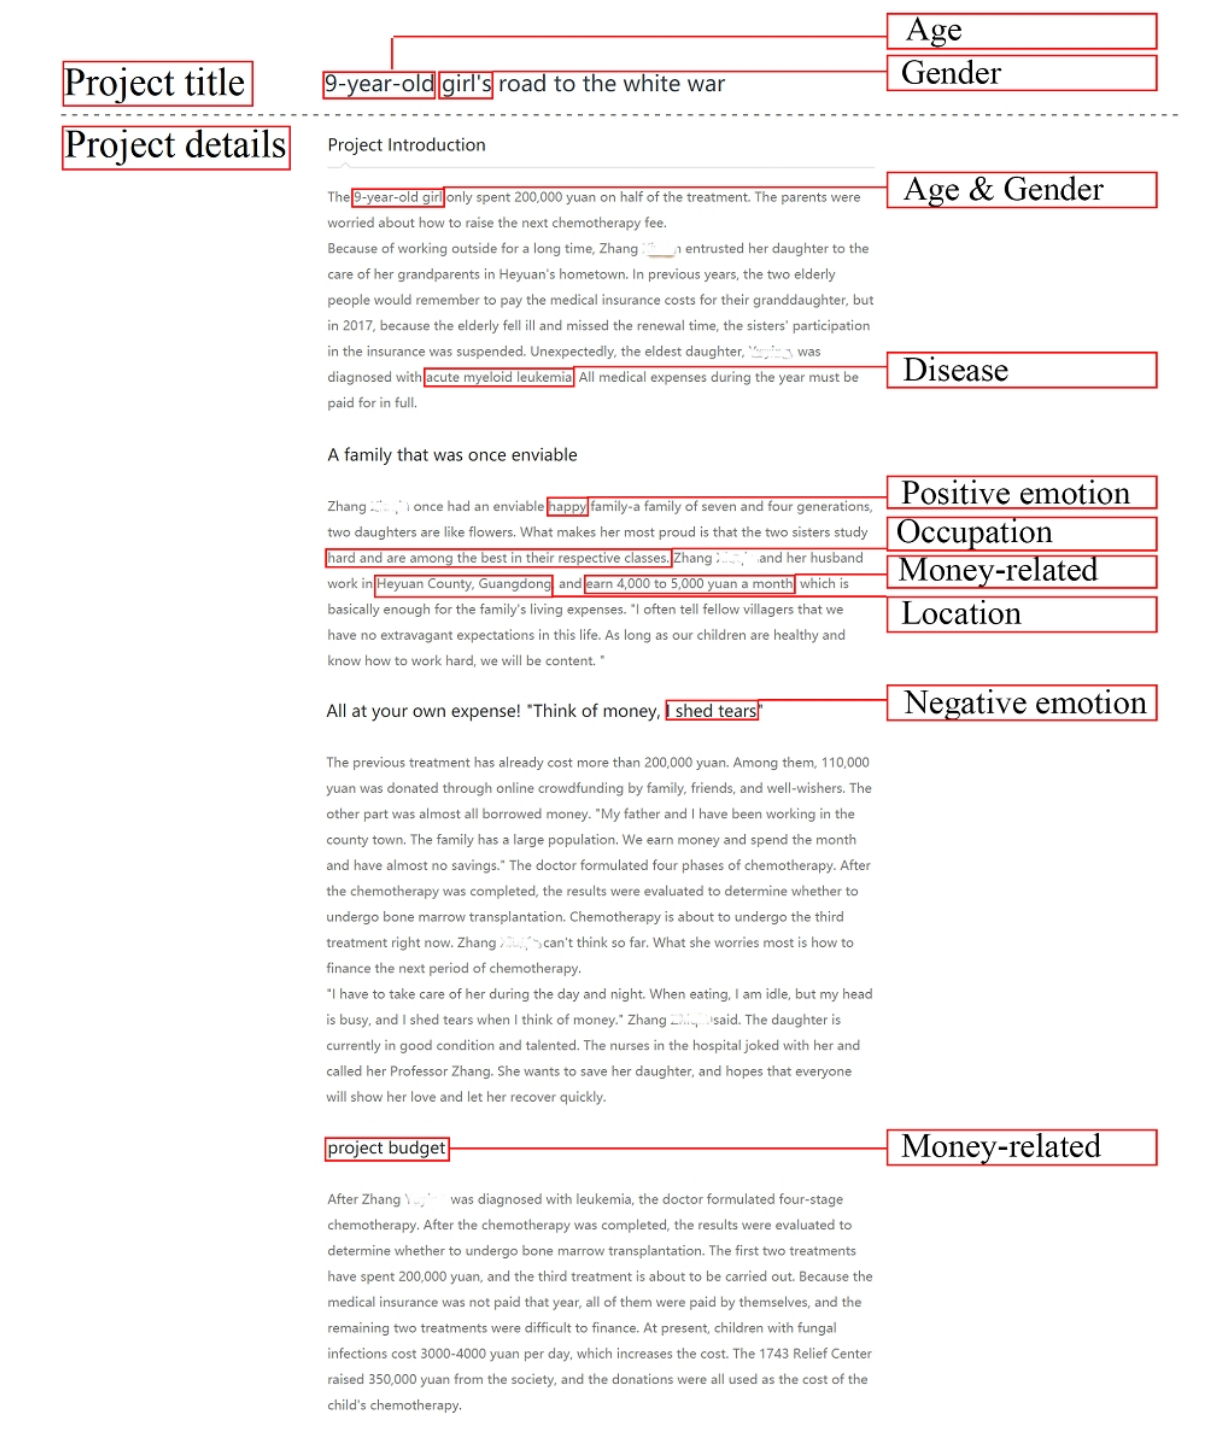
Figure 3. Textual features of a medical crowdfunding